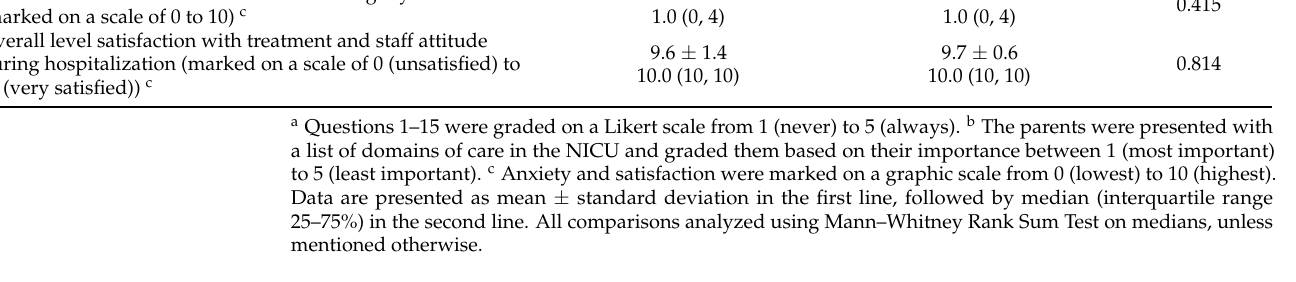
No intervention n = 51